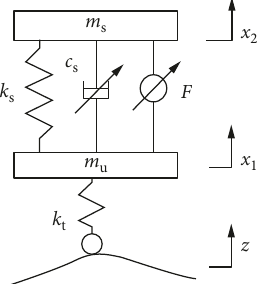
Figure 2: Dynamic model of 2 DOF hybrid active where A , Β , C , and D are the state matrix, input matrix, output matrix, and transfer matrix, respectively. When the control input force F is 0, it becomes passive suspension.